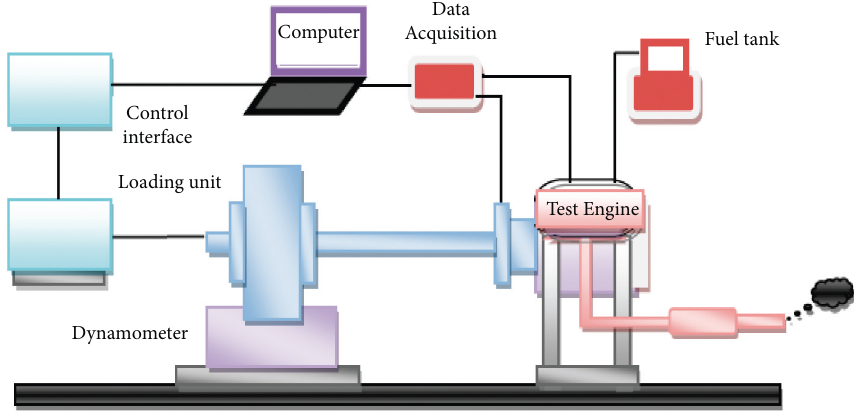
Figure 1: Performance test setup.